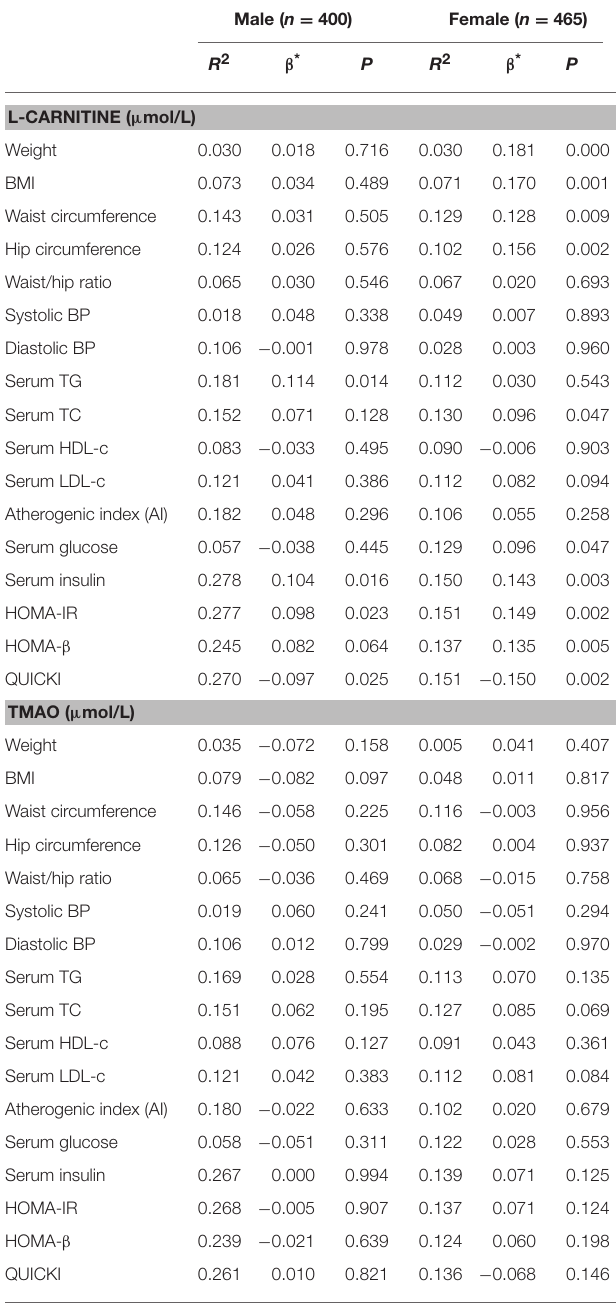
TABLE 5 | Linear Regression analysis of serum L-carnitine, TMAO levels with MS related indexes in subjects with normal fasting glucose levels a